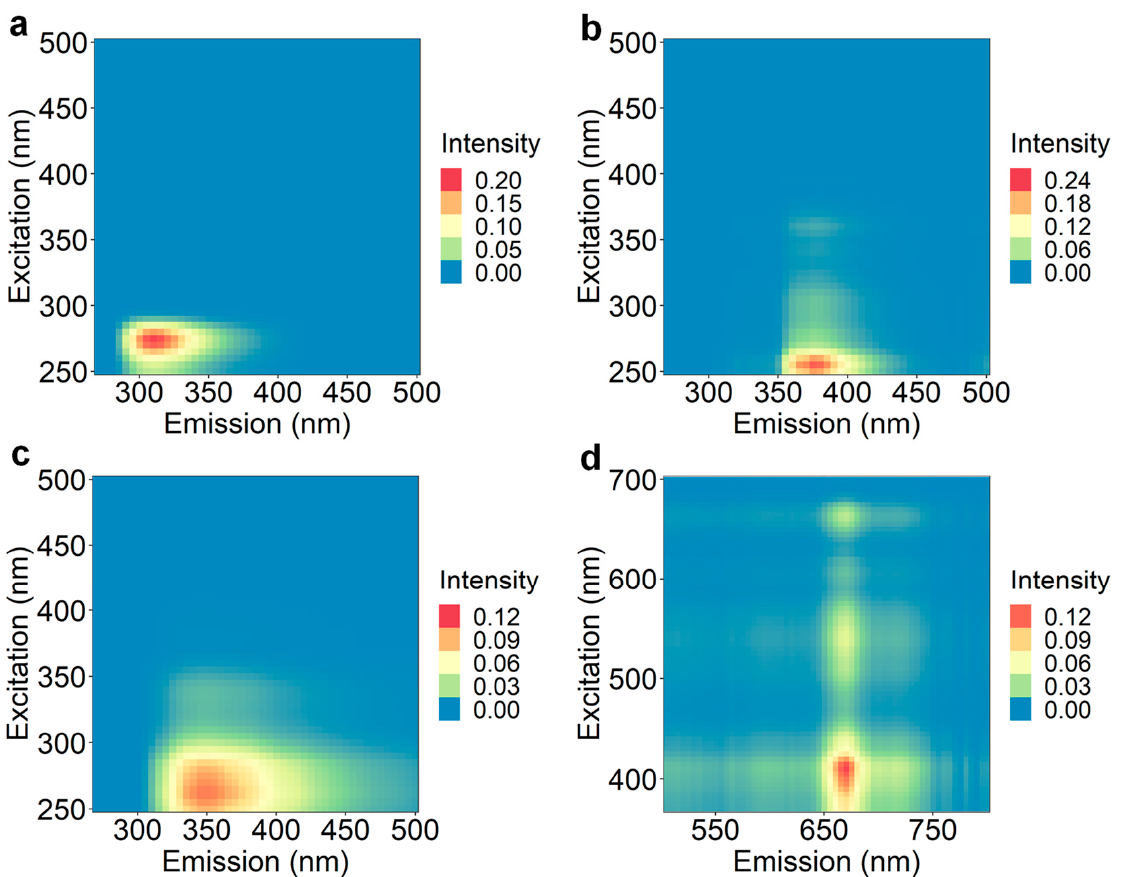
Figure 1. Grape extract excitation and emission maxima from PARAFAC showing ( a ) component 1, ( b ) component 2, and ( c ) component 3 for Model 1, and ( d ) component 1 for Model 2. Three fluorophores were revealed by PARAFAC Model 1: component 1 had